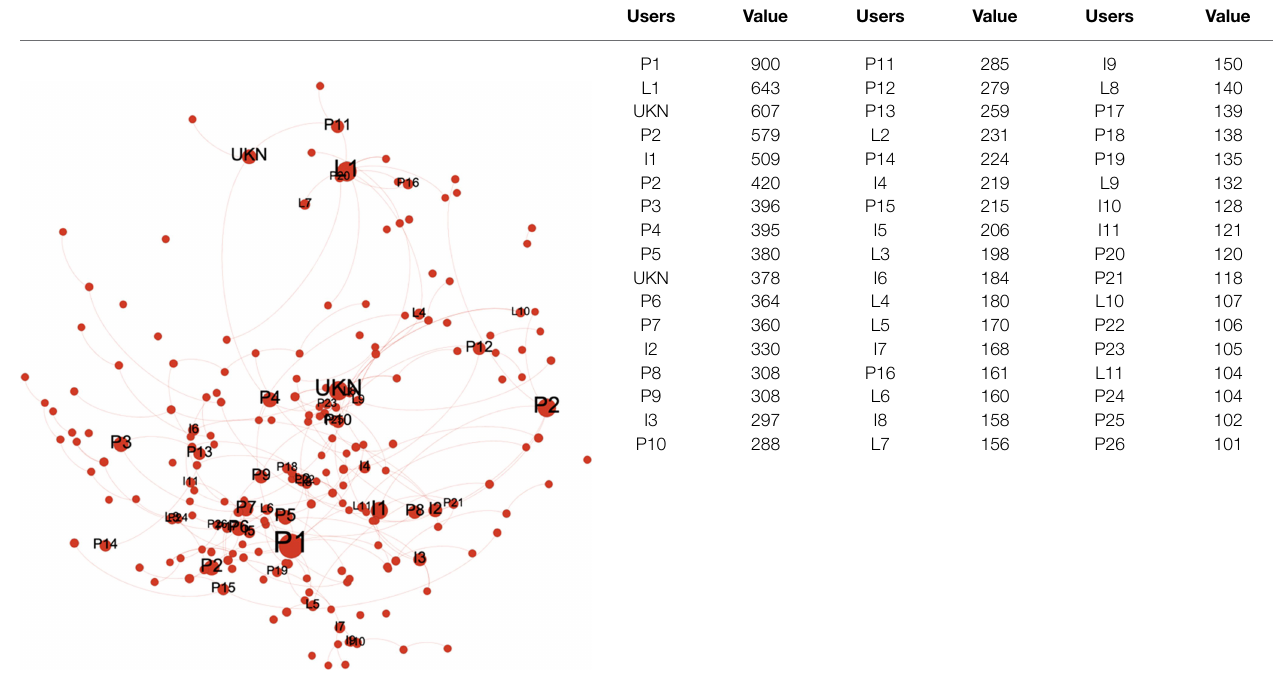
TABLE 6 | Users with betweenness centralities greater than 100.